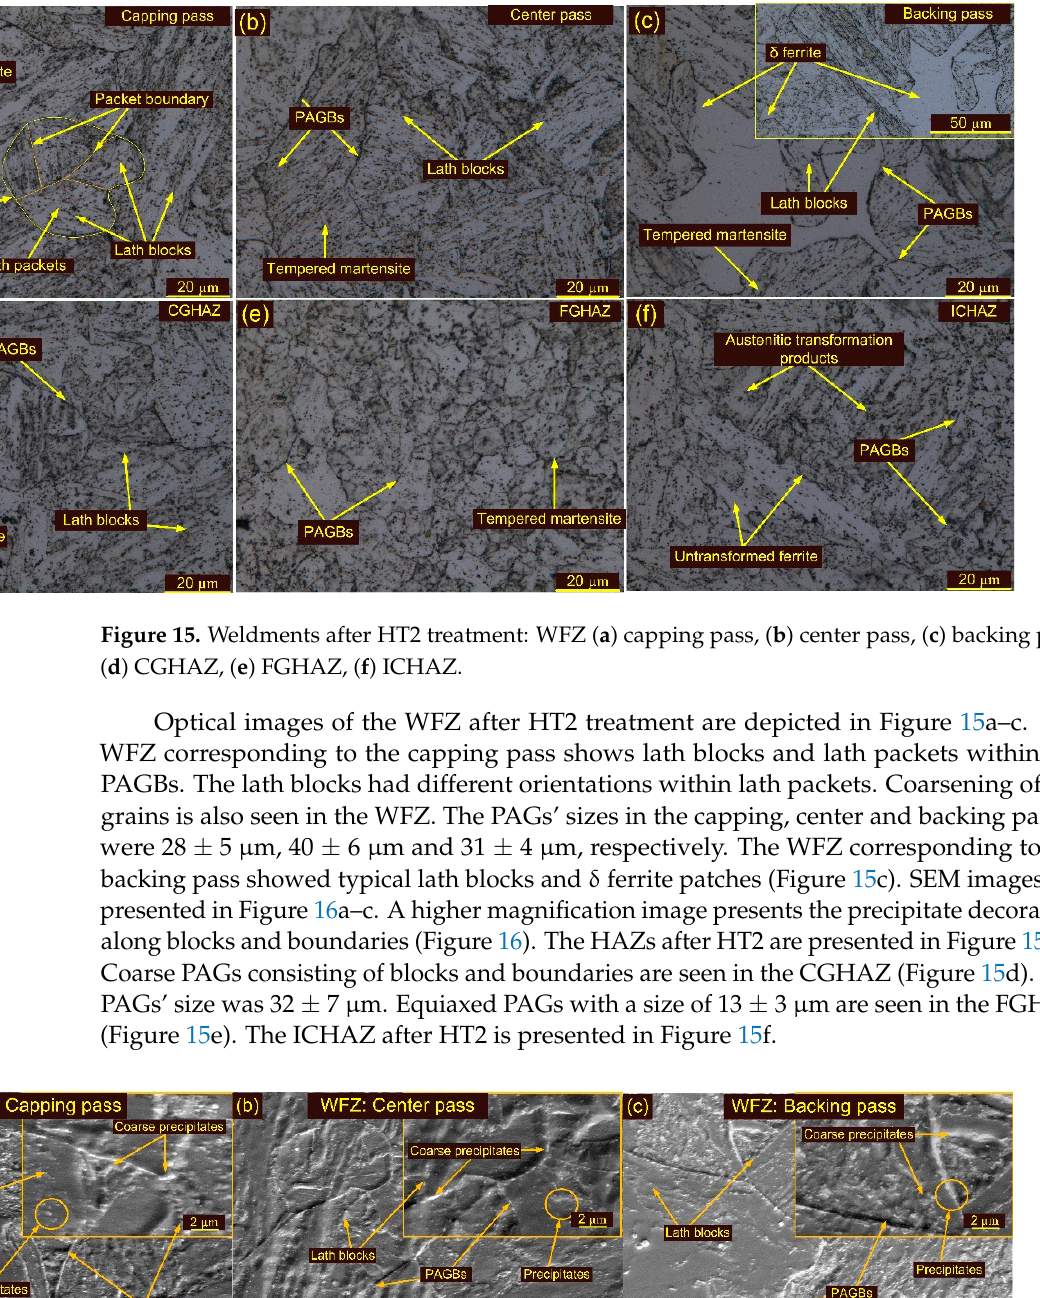
Figure 16. SEM images of weldments after HT2 treatment: WFZ ( a ) capping pass, ( b ) center pass, ( c ) backing pass.